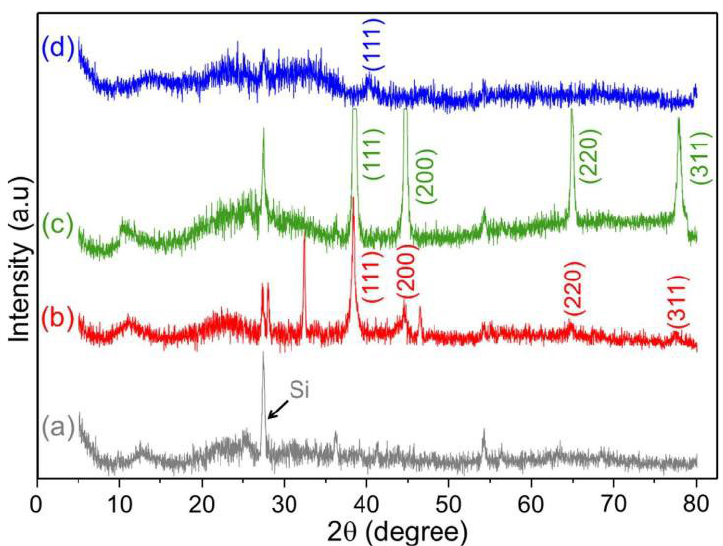
Figure 15. The powder X-ray diffraction patterns of ( a ) delaminated MXene nanosheets, and after hybridization with ( b ) Ag, ( c ) Au and ( d ) Pd nanoparticles. Reprinted with permission from [70]. Copyright 2016 Springer Nature.